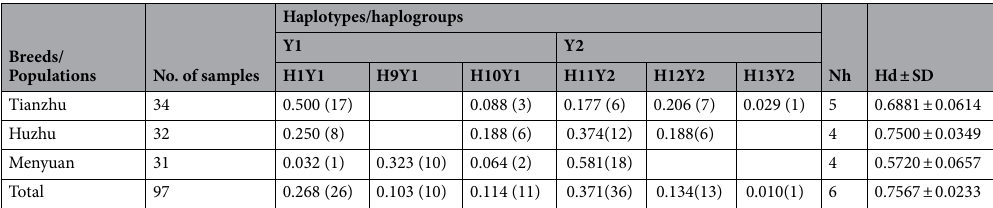
Table 1. Frequencies and diversities of haplotypes in three Chinese white yak breeds/populations. Nh, number of haplotypes; Hd, haplotype diversity; SD, standard deviation.